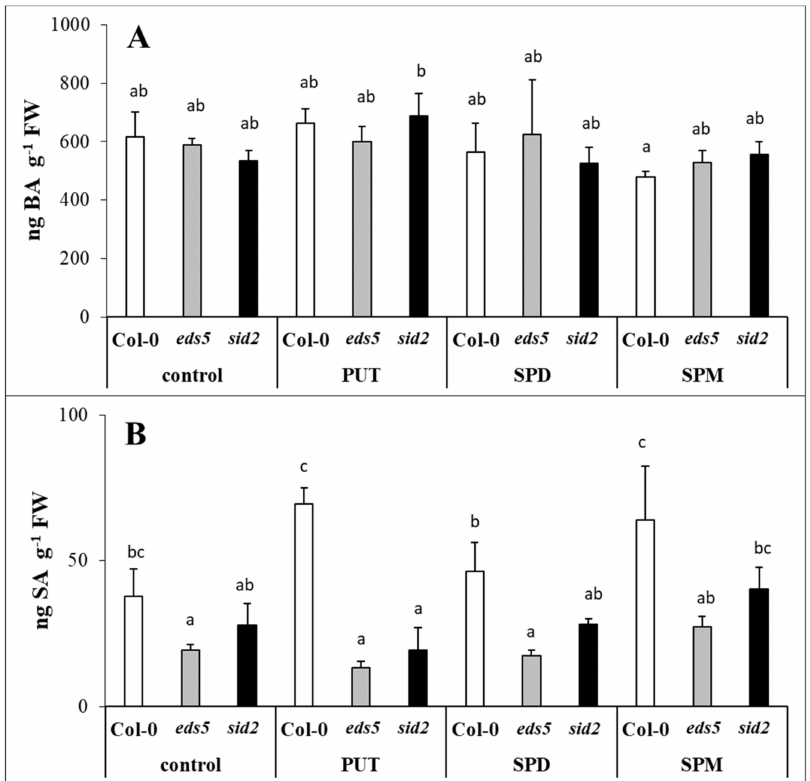
Figure 6. E ff ect of 0.5 mM 1-day of putrescine (PUT), spermidine (SPD) and spermine (SPM) treatments on the contents of benzoic acid (( A ) BA) and salicylic acid (( B ) SA) in Col-0, wild type, eds5-1 ( eds5 ) and sid2-2 ( sid2 ) Arabidopsis mutants. Data represent mean values ± SD. Di ff erent letters indicate significant di ff erences at p ≤ 0.05